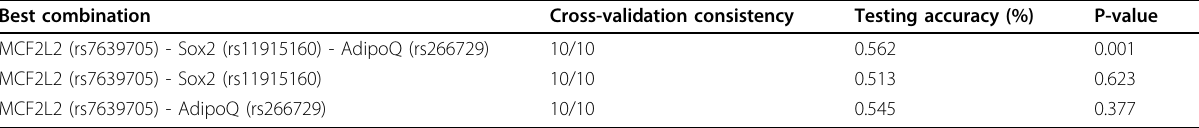
P-values were based upon 1000